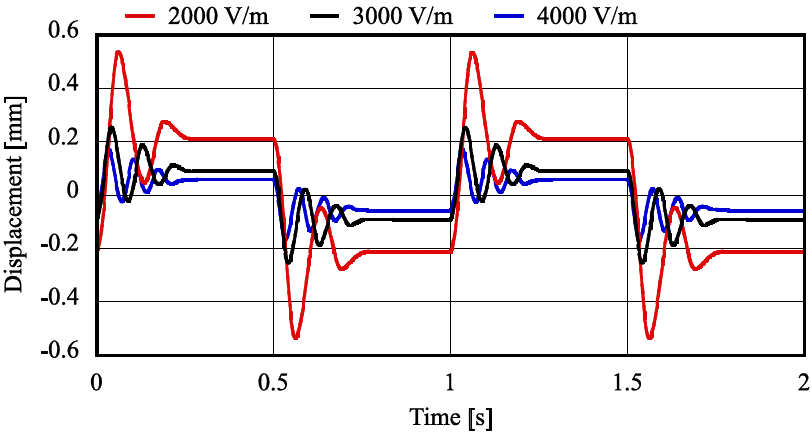
Figure 9. Time histories of displacement with a rectangular disturbance in the FORE-controlled system. The feedback gain p f was 2000 V/m (red line), 3000 V/m (black line), and 4000 V/m (blue line).